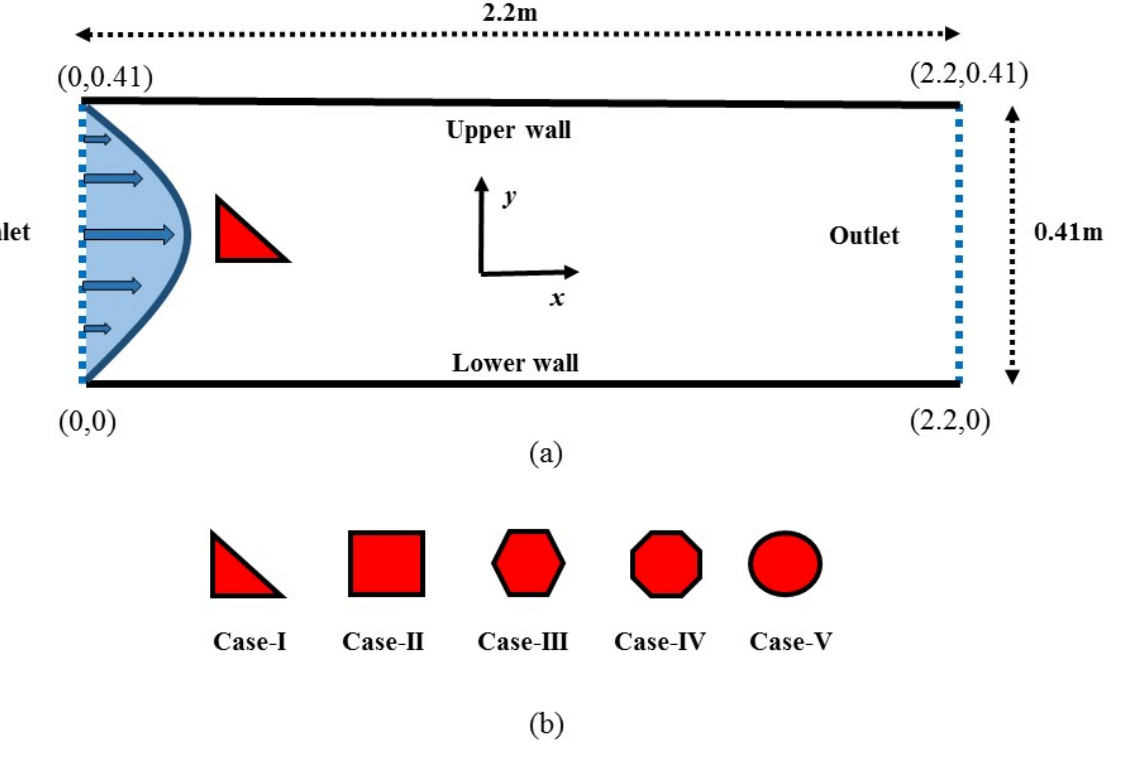
Figure 1. ( a ) Flow geometry of problem. ( b ) Geometric illustration of obstacles.